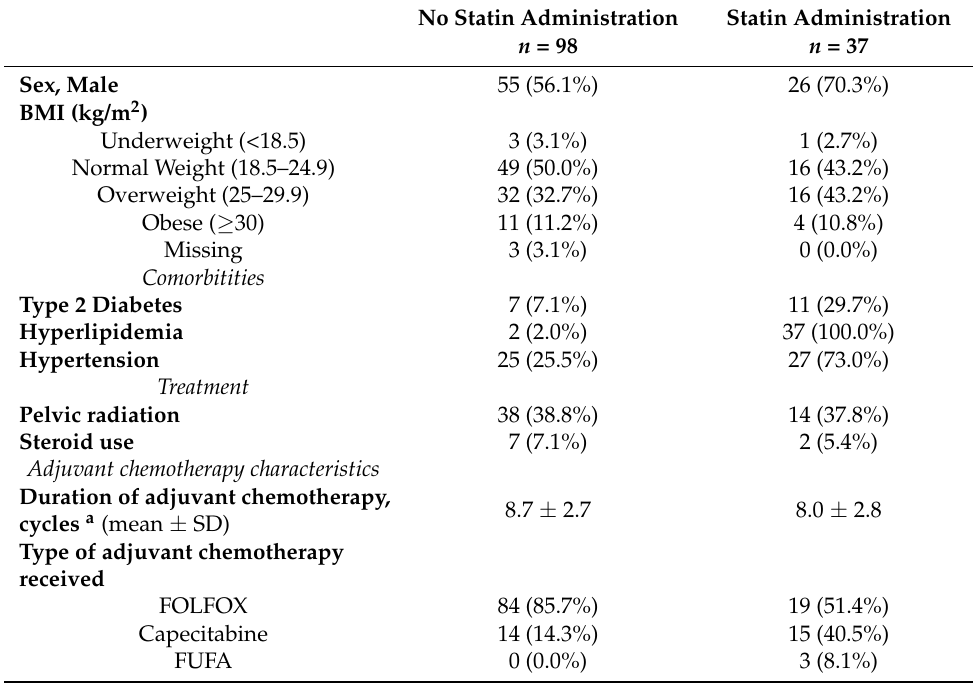
Table 5. Statin use in patients who received adjuvant chemotherapy for their colorectal cancer.